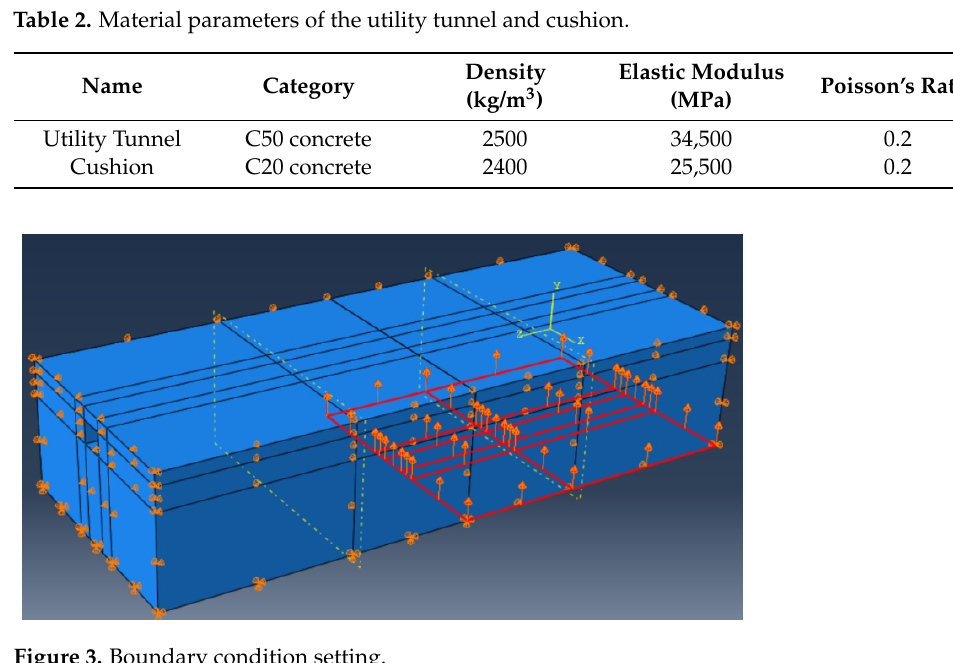
Table 2. Material parameters of the utility tunnel and cushion.